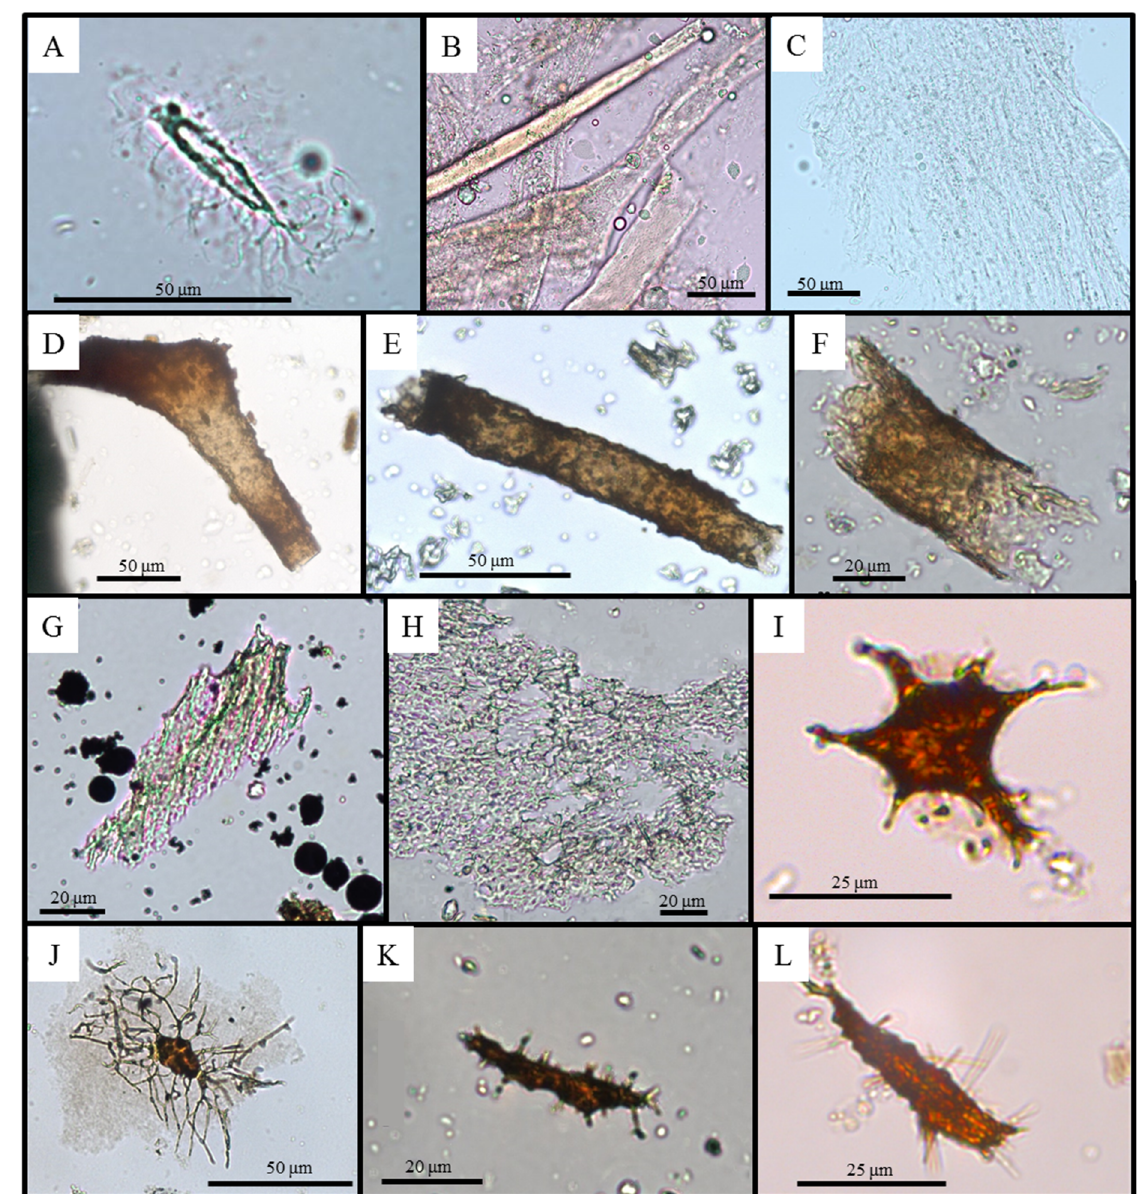
Figure 4. Modern and fossil demineralization products. ( A ) Modern American alligator osteocyte. ( B ) Alligator blood vessels. ( C ) Alligator collagen matrix. ( D , E ) Thoracosaurus (RU-EFP-00006-11) blood vessels. ( F ) Taphrosphys (RU-EFP-00002-2) blood vessel. ( G ) Thoracosaurus (RU-EFP-00006-8) collagen matrix. ( H ) Taphrosphys (RU-EFP-00002-2) collagen matrix. ( I ) Taphrosphys (RU-EFP-02222) stellate osteocyte. ( J ) Testudines indet. (RU-EFP-04161-8) stellate osteocyte. ( K ) Taphrosphys (RU-EFP-04162) flattened oblate osteocyte. ( L ) Euclastes (RU-EFP-00018) flattened oblate osteocyte.